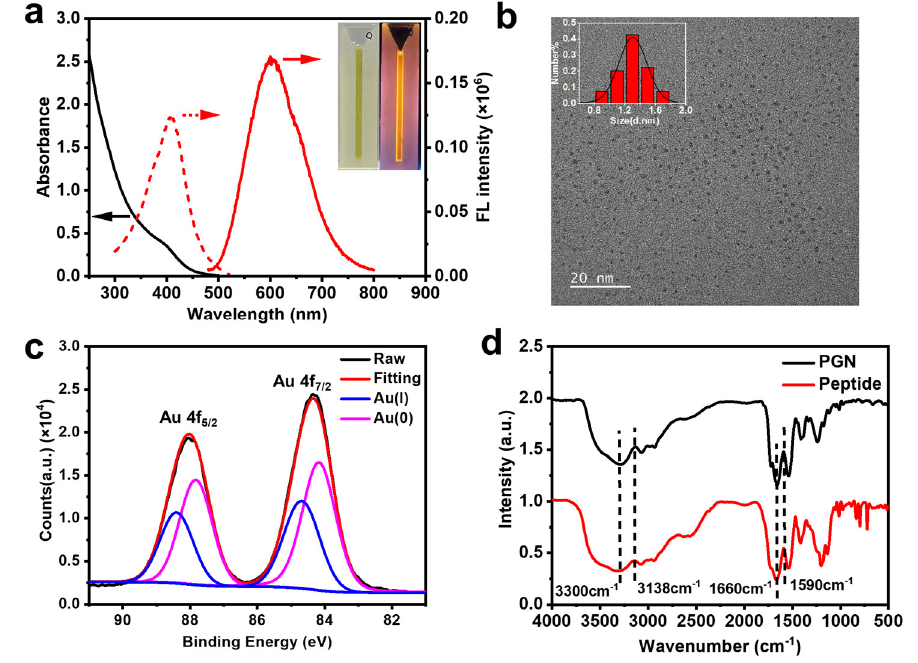
Figure 1. ( a ) UV-Vis absorption spectrum (black line), luminescence excitation (broken red line) and emission spectra (solid red line) of the PGN (peptide protected gold nanoclusters); inset: digital photo of PGN in aqueous solution under visible (left) and UV light (right). ( b ) HRTEM image of the prepared PGN; inset histograms of core sizes. ( c ) High-resolution Au (4f) peaks of the PGN. ( d ) FTIR spectrum of the PGN and the free oligopeptide.